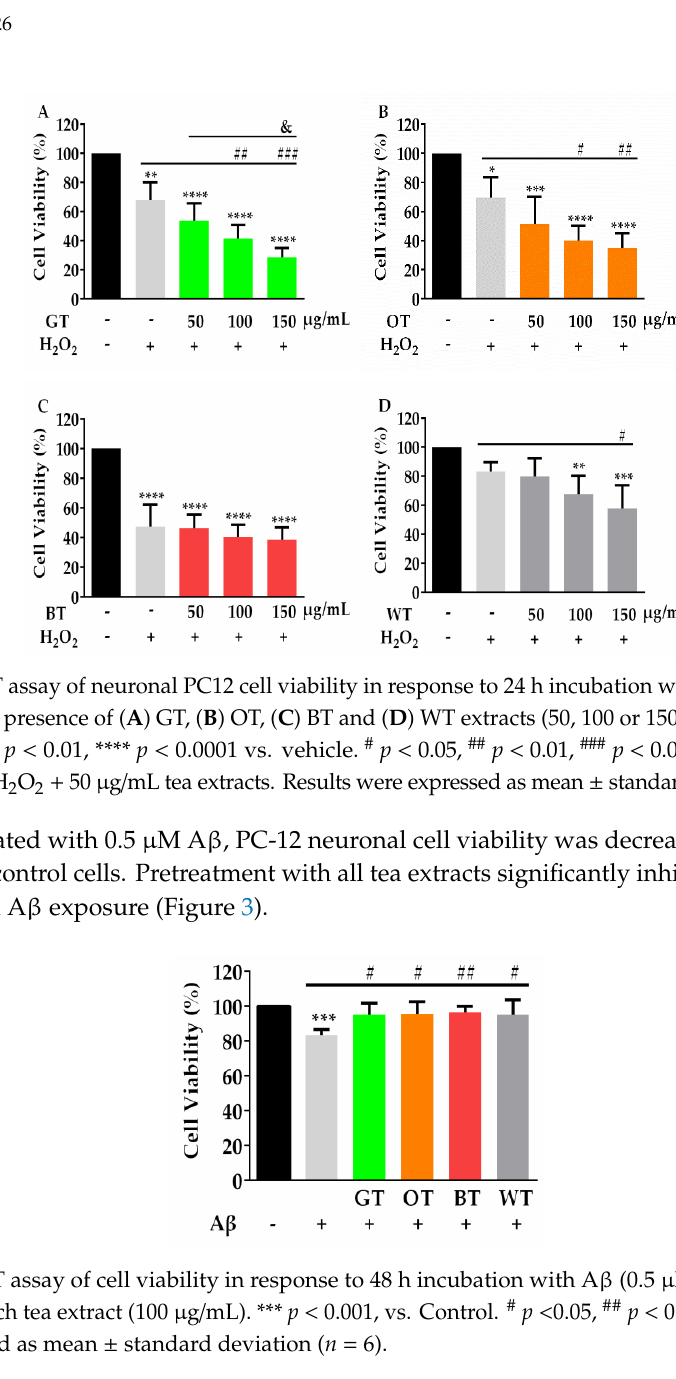
Figure 1. MTT assay of cell viability in response to 24 h incubation with t -bhp (0 – 400 µM), alone or in the presence of ( A ) GT, ( B ) OT, ( C ) BT and ( D ) WT extracts (50, 100 or 150 μg/mL) . * p < 0.05, ** p < 0.01, *** p < 0.001, **** p < 0.0001 vs vehicle. # p < 0.05, ## p < 0.01, ### p < 0.001, #### p < 0.0001 vs 150 μg/mL. Results were expressed as mean ± standard deviation ( n = 4).